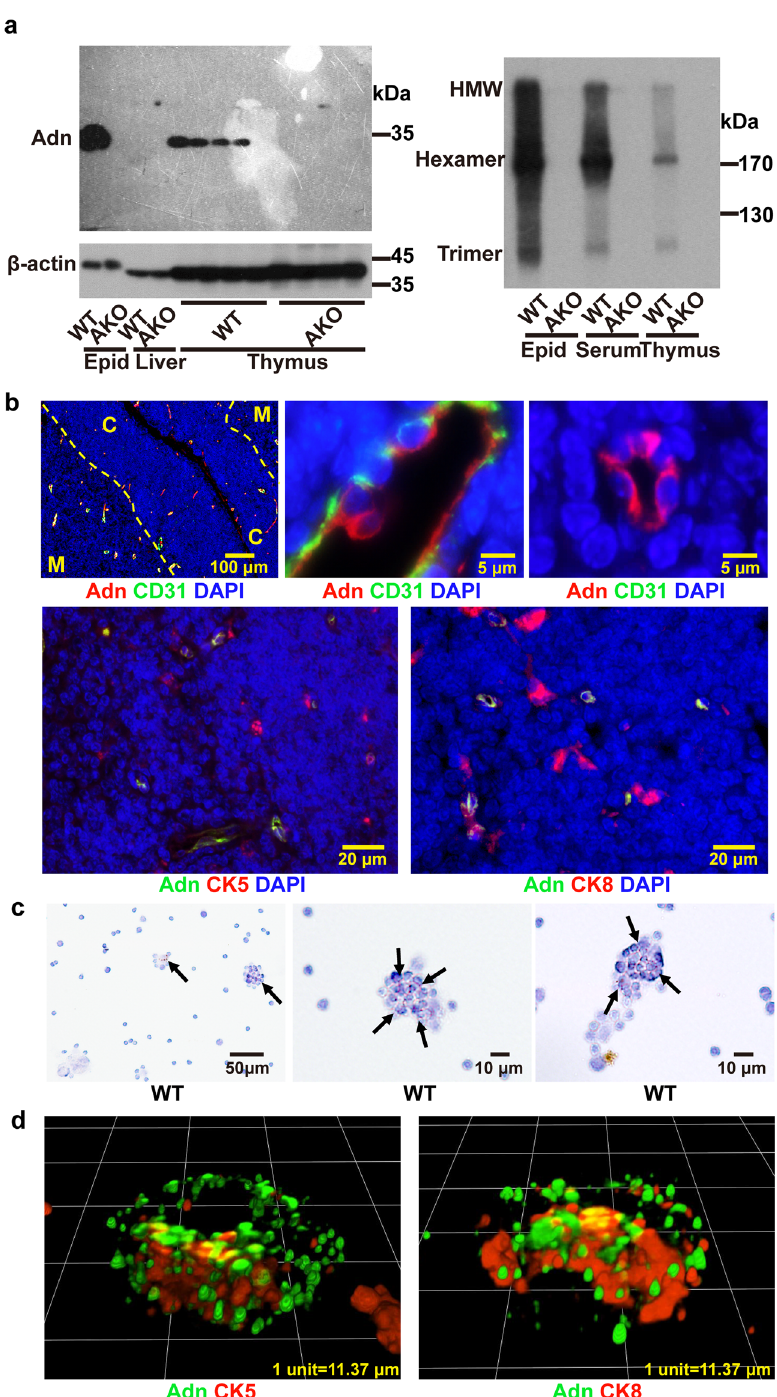
Fig. 1 Adiponectin is expressed in thymus. a Wild-type [WT] or adiponectin knockout [AKO] mice were sacri fi ced at the age of 7 weeks to collect epididymal adipose tissue [epid], liver, and thymus. Adiponectin [Adn] protein expression was analyzed by denatured ( left ) or non-reducing ( right ) SDS- PAGE and detected by Western blotting using a polyclonal antibody recognizing murine adiponectin. Beta-actin ( β -actin) was probed as loading controls. b Immuno fl uorescence staining was performed to examine the expression and distribution of Adn protein in the thymus of WT mice. The tissue sections were counterstained for CD31, cytokeratin [CK] 5, CK8 and DAPI. C and M indicate cortex and medulla, respectively. c In situ hybridization was performed for detecting the mRNA transcripts of ADIPOQ in cell suspensions isolated from the thymus of WT mice. Positive brown signals were indicated by black arrows. d Confocal fl uorescence microscopy was applied to analyze the protein expression and distribution of Adn (green) in TNC complexes isolated from WT thymus. The sections were counterstained (red) for CK5 and CK8.